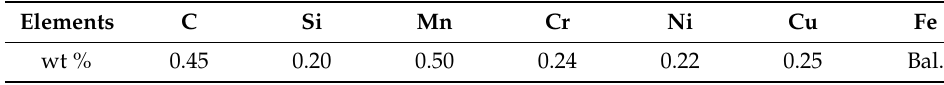
Table 1. Chemical composition of AISI 1045 steel.